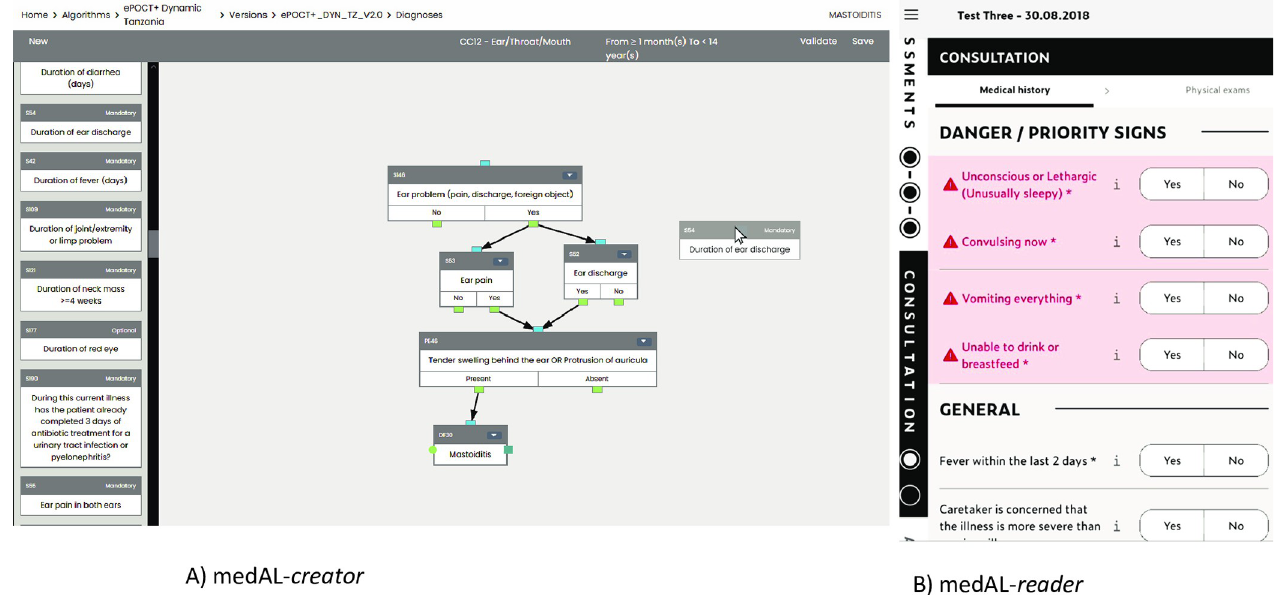
Fig 3. medAL- creator and medAL- reader . A) medAL- creator and its “drag and drop” user interface to design the clinical algorithm. For each clinical element a description and/or photo can be included to assist the end-user using medAL- reader ; B) medAL- reader the android based application to collect the medical history, exposures, symptoms, signs and tests, and then propose the appropriate diagnosis and